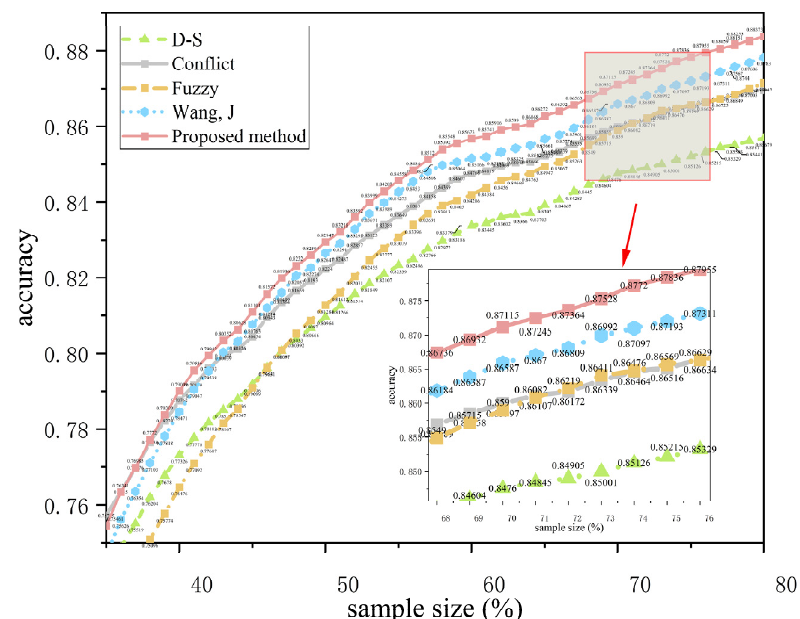
Figure 4. Accuracy of different methods with three sensors [4].